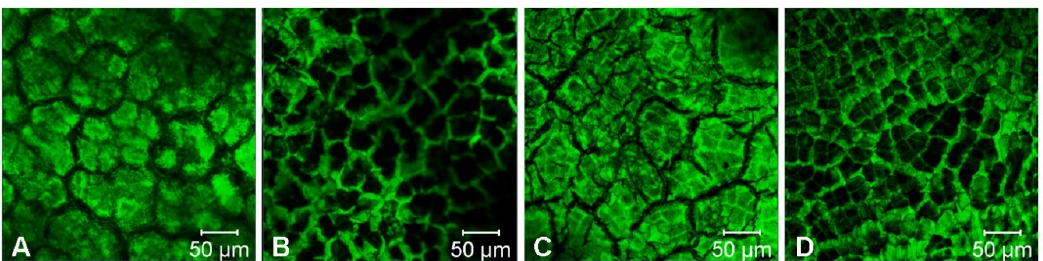
Figure 3. Confocal laser scanning microscopy (CLSM) micrographs of cutins from “golden delicious” (( A ) outer face and ( B ) inner face) and “red” (( C ) outer face and ( D ) inner face) apples.